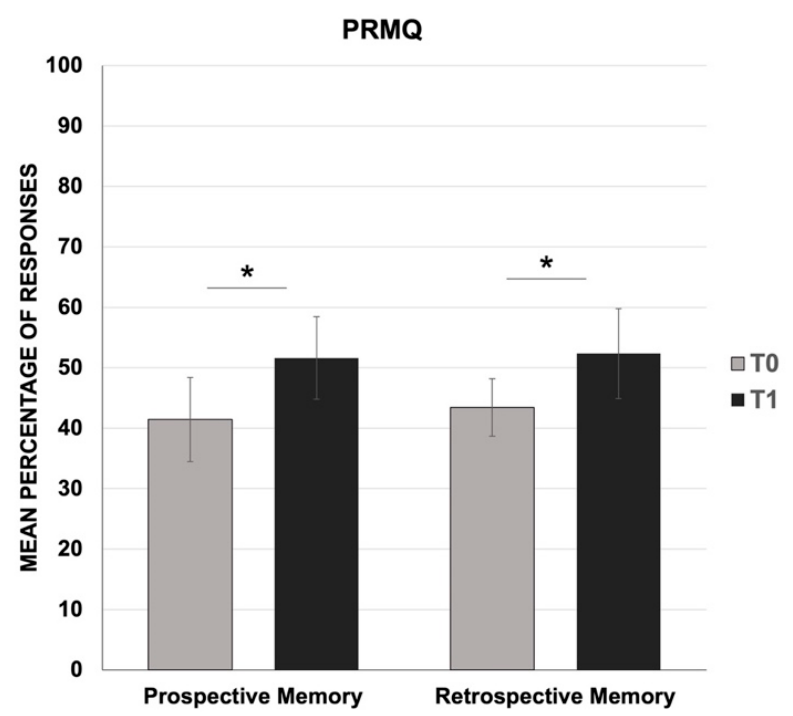
Figure 2. Mean percentage of responses for prospective and retrospective memory scales (PRMQ) at two time-points: one month before (T0) and one month after the COVID-19 confinement (T1). * p < 0.001 T0 vs. T1. Table 2. The mean scores of the prospective memory scale (PRMQ) at T1 compared to normative data [64].